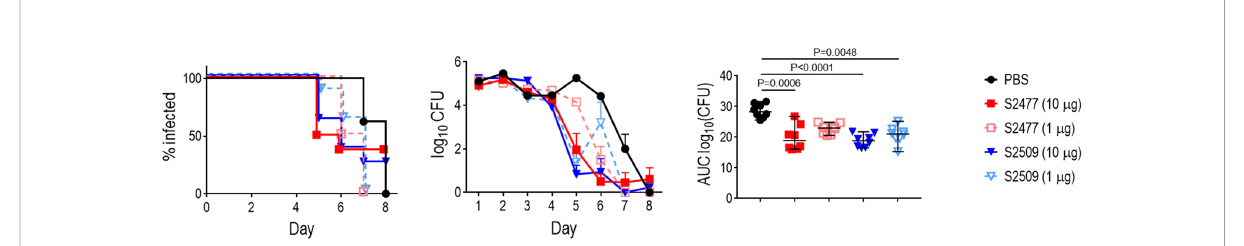
FIGURE 3 Ef fi cacy of S2477 (FH*/Fc1) and S2509 (Fc1/FH*) against N. gonorrhoeae FA1090 in human FH/C4BP transgenic mice. Premarin ® -treated 6-8 week-old human FH/C4BP transgenic mice (n=8/group) were infected with 2.8 x 10 7 CFU N. gonorrhoeae FA1090. Mice were treated daily (starting 2 h before infection) intravaginally either with PBS (vehicle control) or with 1 µg or 10 µg of S2477 or S2509. Left graph : Kaplan Meier curves showing time to clearance, analyzed the Mantel-Cox (log-rank) test. Middle graph : log 10 CFU versus time. X-axis, day; Y-axis, log 10